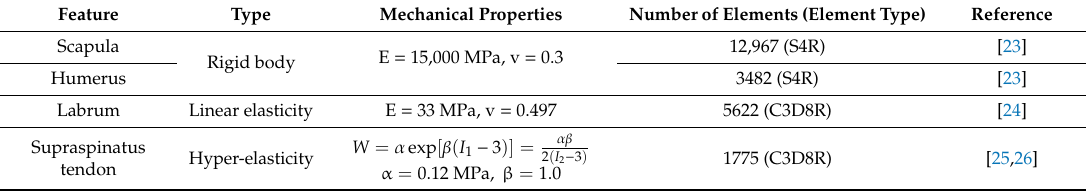
Table 1. Parameters of material properties used in the proposed method.